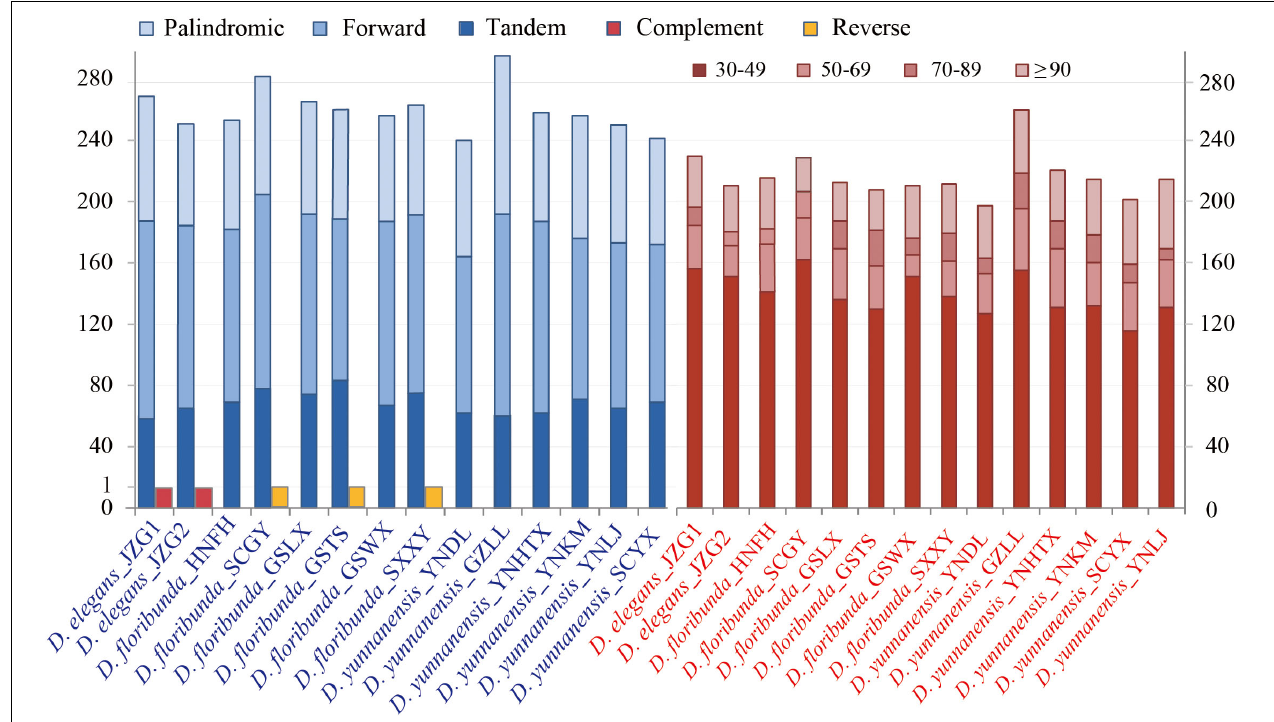
FIGURE 2 | Analysis of repetitive sequences in 14 Dipelta chloroplast genomes. The blue histogram on the left indicates the number of five repeat types. The red histogram on the right shows the frequency of the five repeat types by